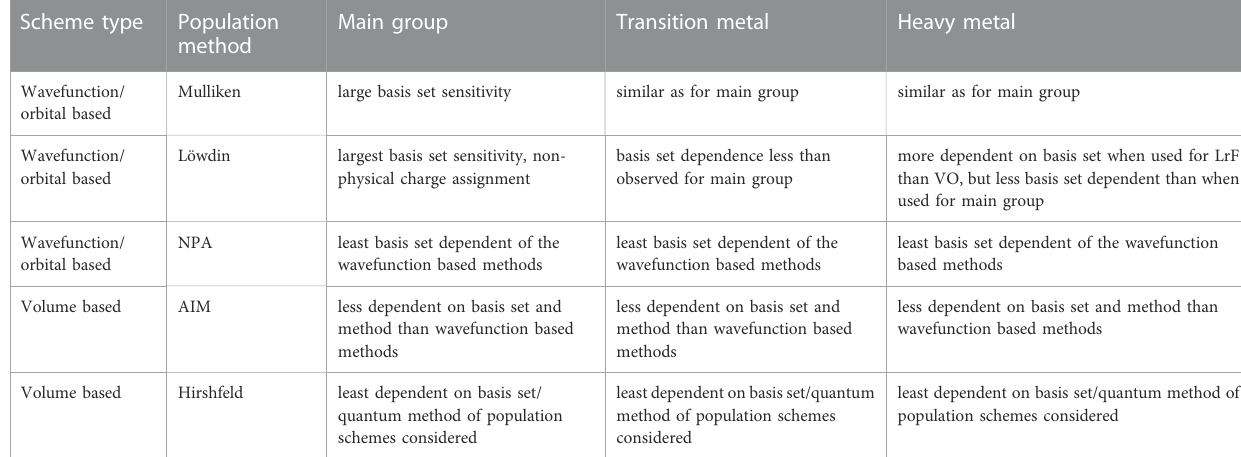
TABLE3Basissetandquantummethoddependenciesfromwavefunctionandvolumebasedpopulationanalysismethodsappliedtomaingroup,transitionmetal and heavy metal